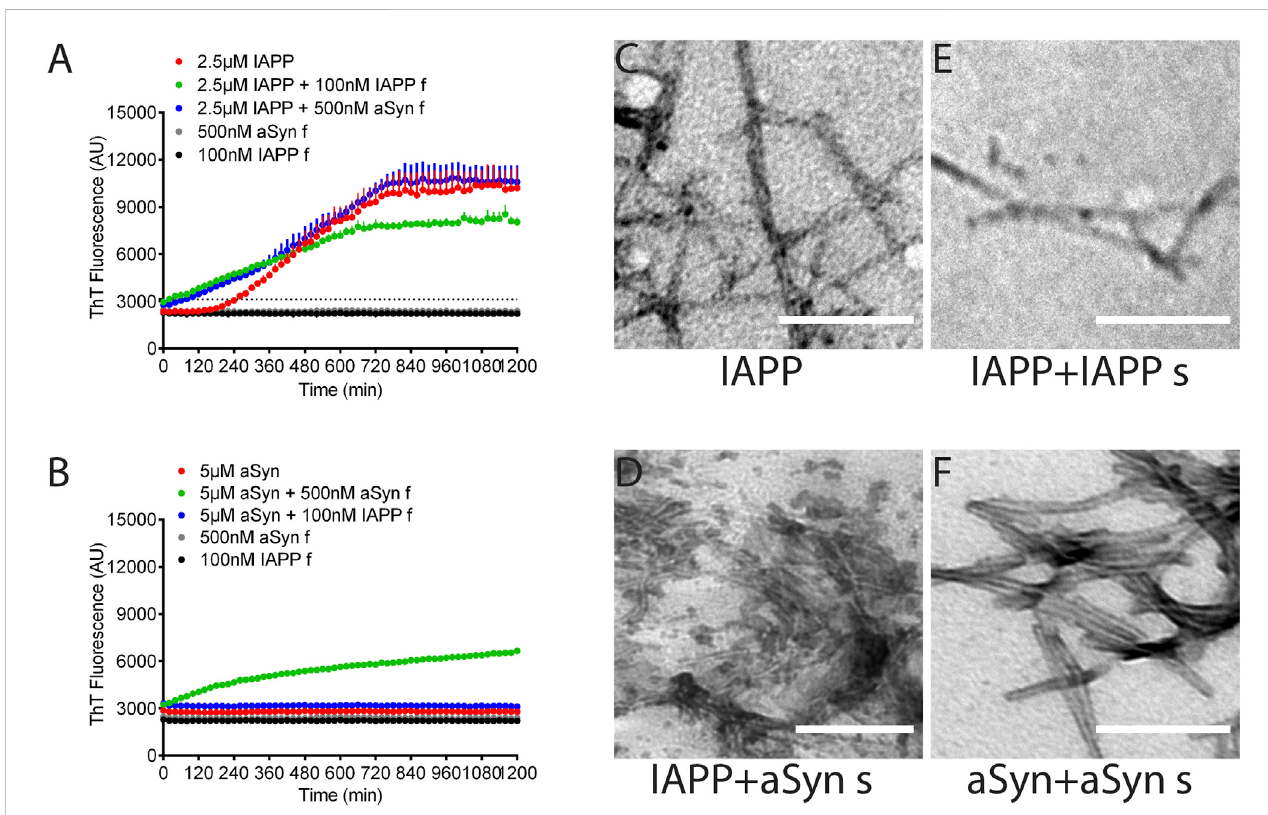
FIGURE 4 aSynseedsIAPP fi brilformation, not vice versa . (A) ,Thelag phaseofIAPP fi brilformationwas4 h(red).TheadditionofIAPPseedsdrastically reducedthe lag phase to 20 min (green), while the addition of aSyn seeds reduced the lag phase to 80 min (blue). (B) ASyn alone did not form fi brils under the examined experiment condition (red). Adding aSyn seeds induced aSyn fi bril formation (green), while adding IAPP seeds did not induce aSyn fi bril formation (blue). Each data point represents mean ± SD ( n = 4). Electron micrographs visualize amyloid fi brils formed by (C) IAPP, (D) IAPP with aSyn seeds, (E) IAPP with IAPP seeds, and (F) aSyn with aSyn seeds. Scale bar: 200